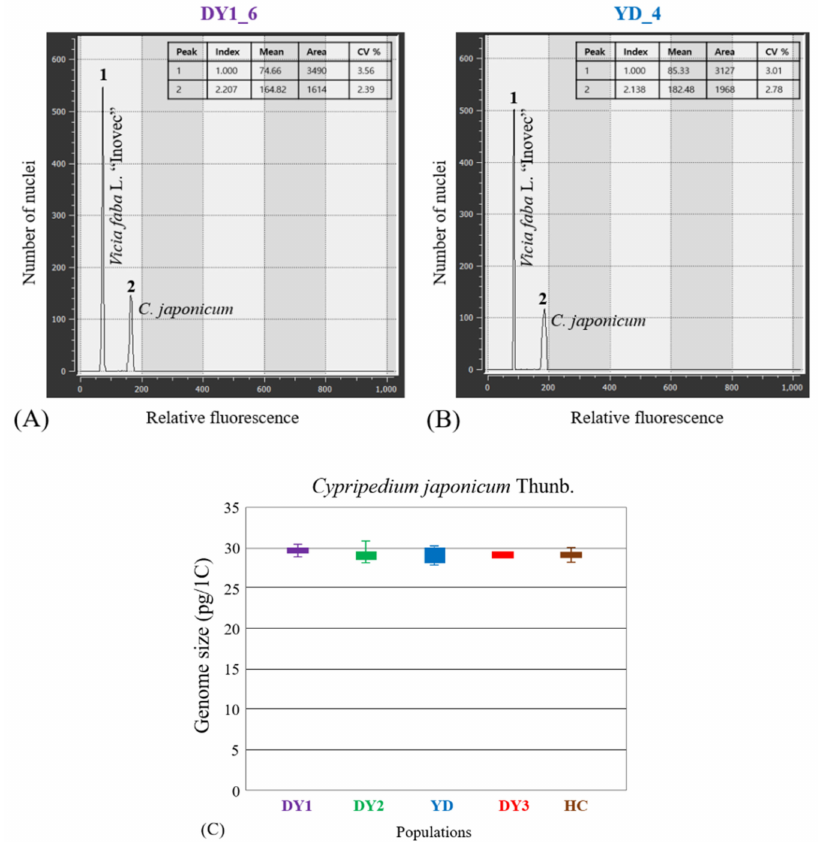
Figure 3. Fluorescence histogram results of Cypripedium japonicum with an internal reference standard ( Vicia faba L. “Inovec”: 13.45 pg/1C). ( A ) DY1_6 (population_individual; Mt. Deokyu population), ( B ) YD_4 (population_individual; Youngdong-gun population), ( C ) Distribution of genome size